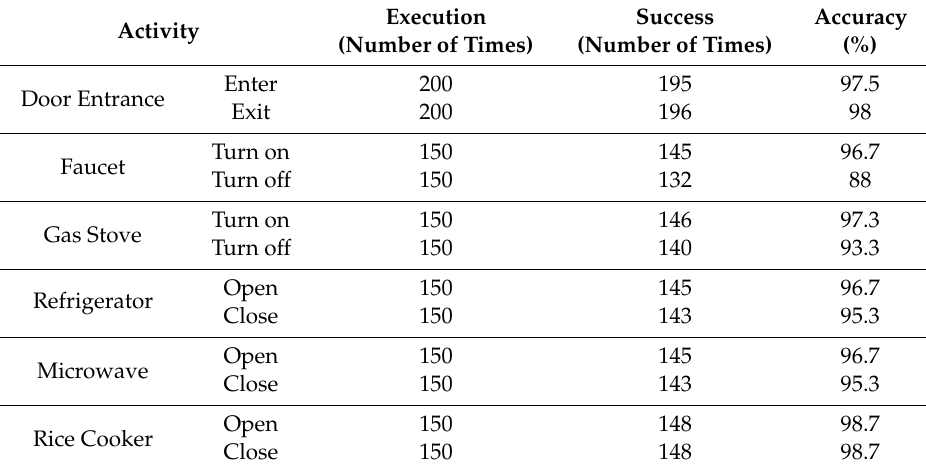
Table 2. Accuracy of activity